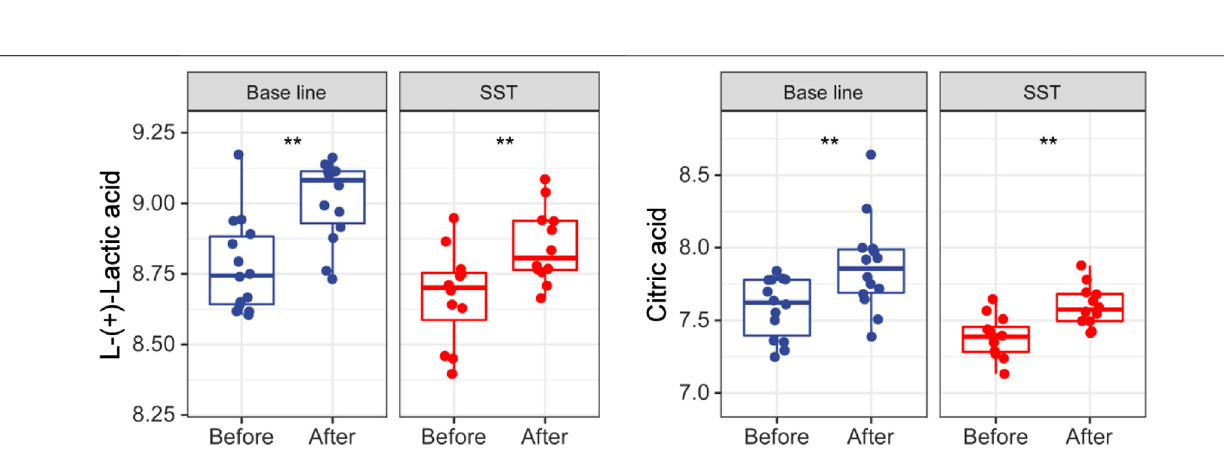
Frontiers in Pharmacology |